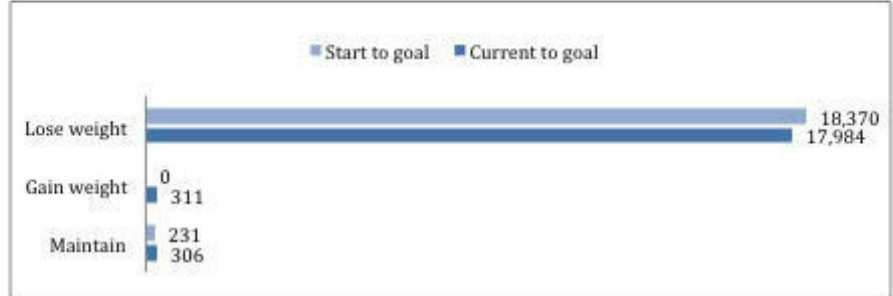
Figure 1. Number of users who had weight loss goals and weight gain